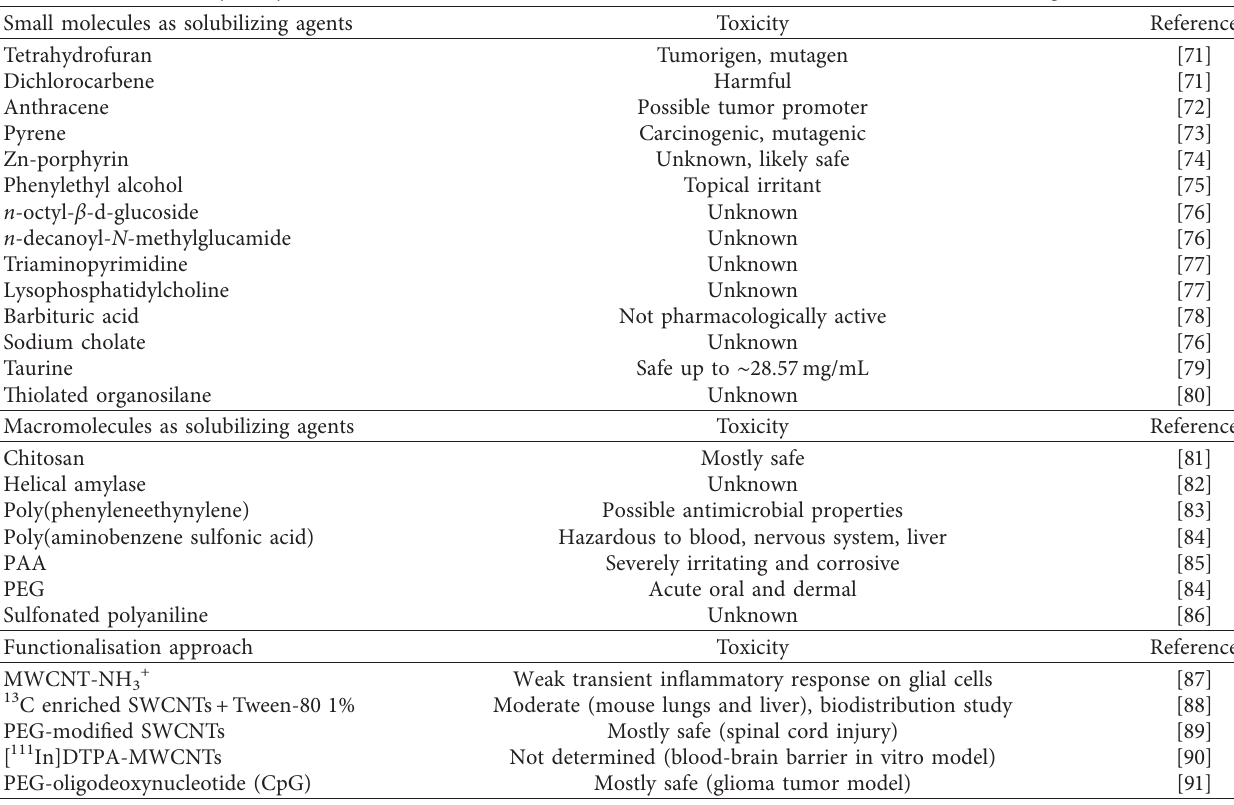
Table 1: Toxicity study of various carbon nanotubes solubilization and functionalisation schemes of biological interest. Small molecules as solubilizing